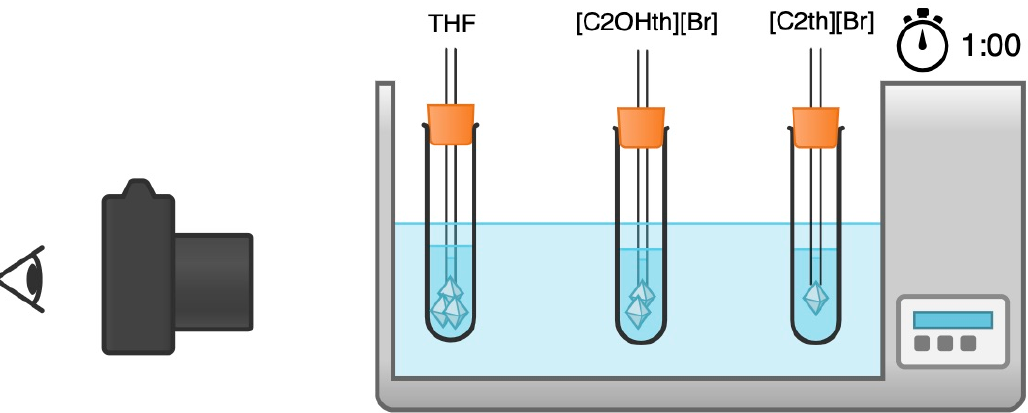
Figure 10. Schematic representation of the screening experiments for the ILs as THF hydrate crystal growth inhibitors. The figure was drawn using the free version of online Chemix ® software.